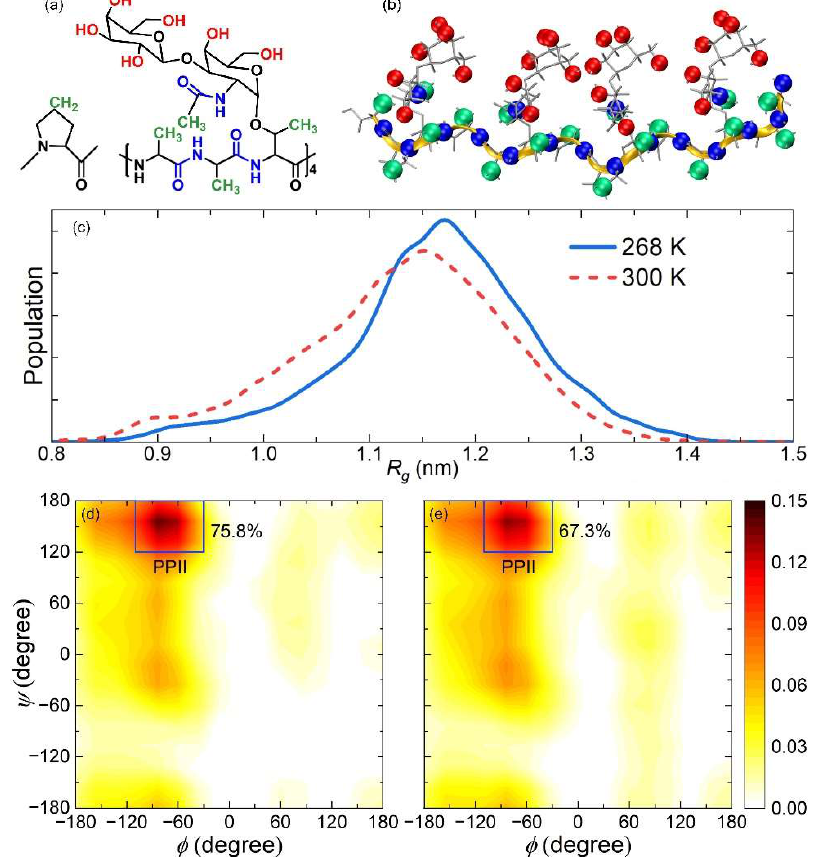
Figure 1. The Structure of AFGP8. ( a ) Sequence of AFGP8 is Ala-Ala-T*-Ala-Ala-T*-Pro-Ala-T*-Ala-Ala-T*-Pro-Ala, where T* denotes the glycosylated Thr. ( b ) The three-dimensional structure with PPII helix conformation of AFGP8, and the key groups, are heighted with the balls: methyl groups (green balls), amide groups (bule balls) and hydroxyl groups (red balls). ( c ) Distribution of the radius of gyration Rg of AFGP8 in solution at 268 K (solid blue line) and 300 K (dashed red line). Ramachandran plots of AFGP8 at 268 K ( d ) and 300 K ( e ). Darker colors represent the higher specific gravity of the secondary structures. The populations of PPII helix integrated inside the region heighted with a blue square are also shown.